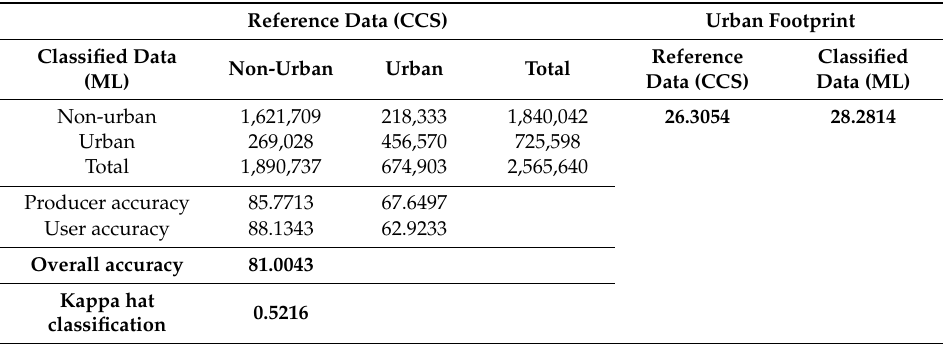
Figure 7. ( a ) Supervised classification (using maximum likelihood (ML) classifier) run over an interferometric coherence image including both polarizations (VH and VV), processed from two Sentinel-1A images acquired in February 2019. ( b ) Accuracy assessments using CCS as a reference map. This image displays the distribution of correctly classified and misclassified pixels. The black and green pixels are related to pixels correctly classified as “non-urban” and “urban”, respectively. In red are pixels erroneously classified as urban pixels (non-urban in the CCS)—false positives; whereas in blue are urban pixels in the CCS, but classified as “non-urban” in the ML classification—false negatives. Table 3. Error matrix related to ML classification performed on the coherence image from February 2019. Urban footprint is computed as the percentage of urban pixels over the total number of